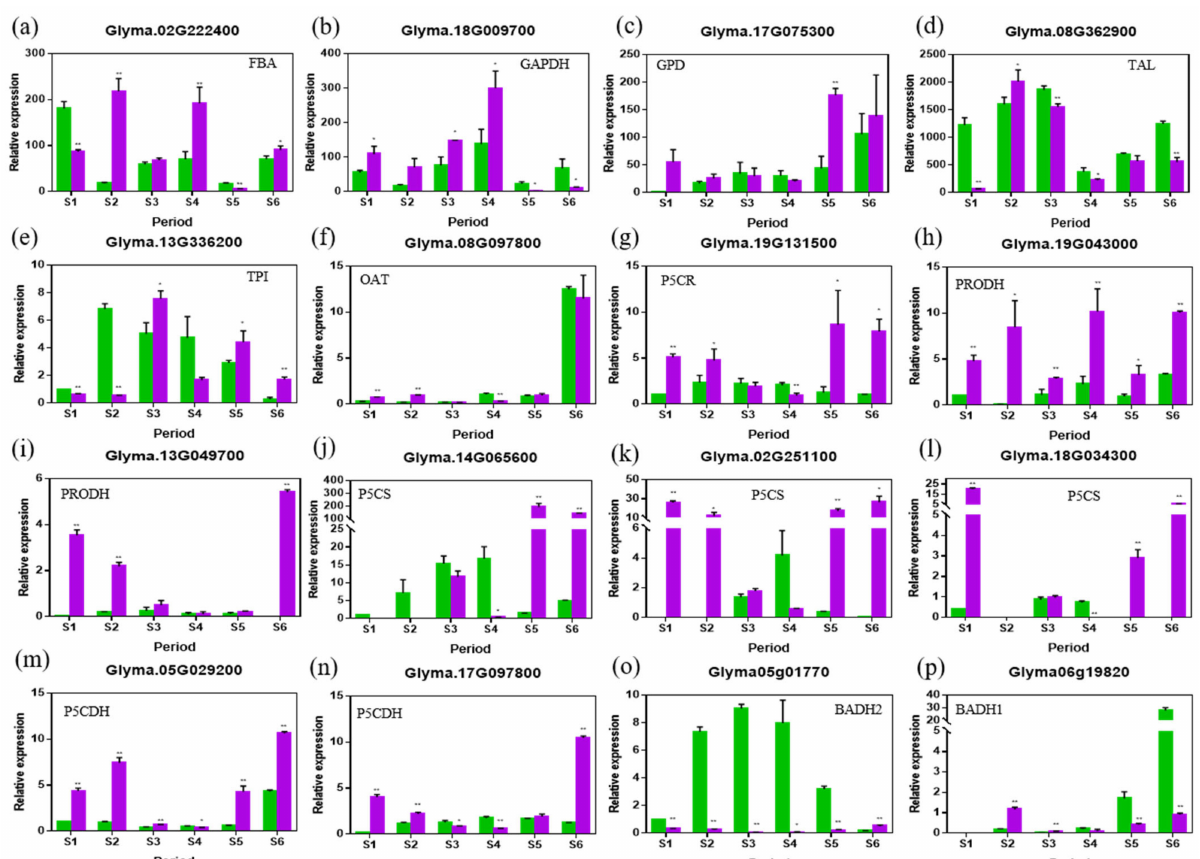
Figure 5. Relative expression levels of 2AP synthesis pathway-related genes in soybean grain ( a – p ). Green column: ZX8 (non-aromatic soybeans), violet column: ZK1754 (aromatic soybeans). S1, S2, S3, S4, S5, S6 for soybean grains correspond to 15, 20, 25, 30, 35, 40 days after anthesis. The actin gene was used as an internal reference. Experiments were performed using three independent biospecimens. Error bars: standard deviation. Significance was tested by comparing the expression of each gene in the green column at each period. * Indicates significance at the p < 0.05 level, ** indicates significance at the p < 0.01